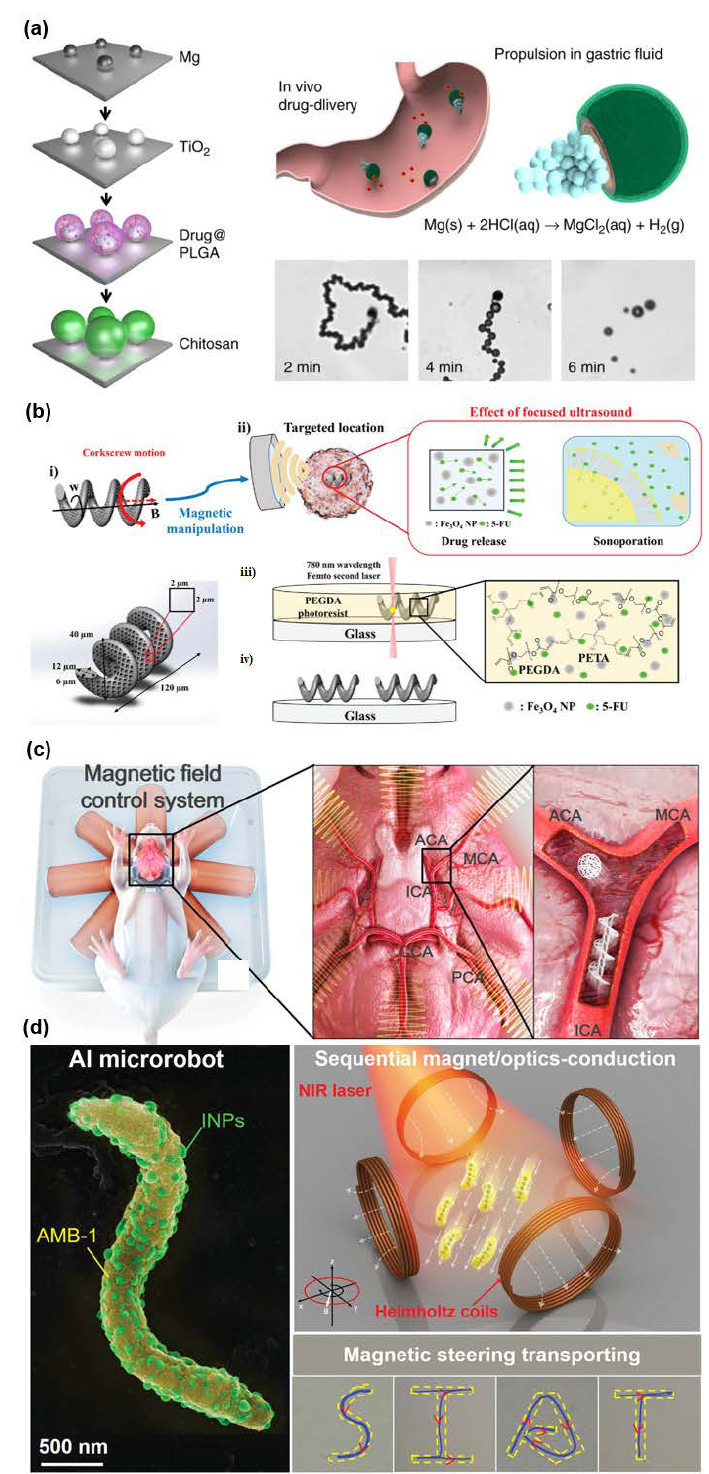
Figure 4. Examples of the application of micro/nanorobots as drug carriers in disease